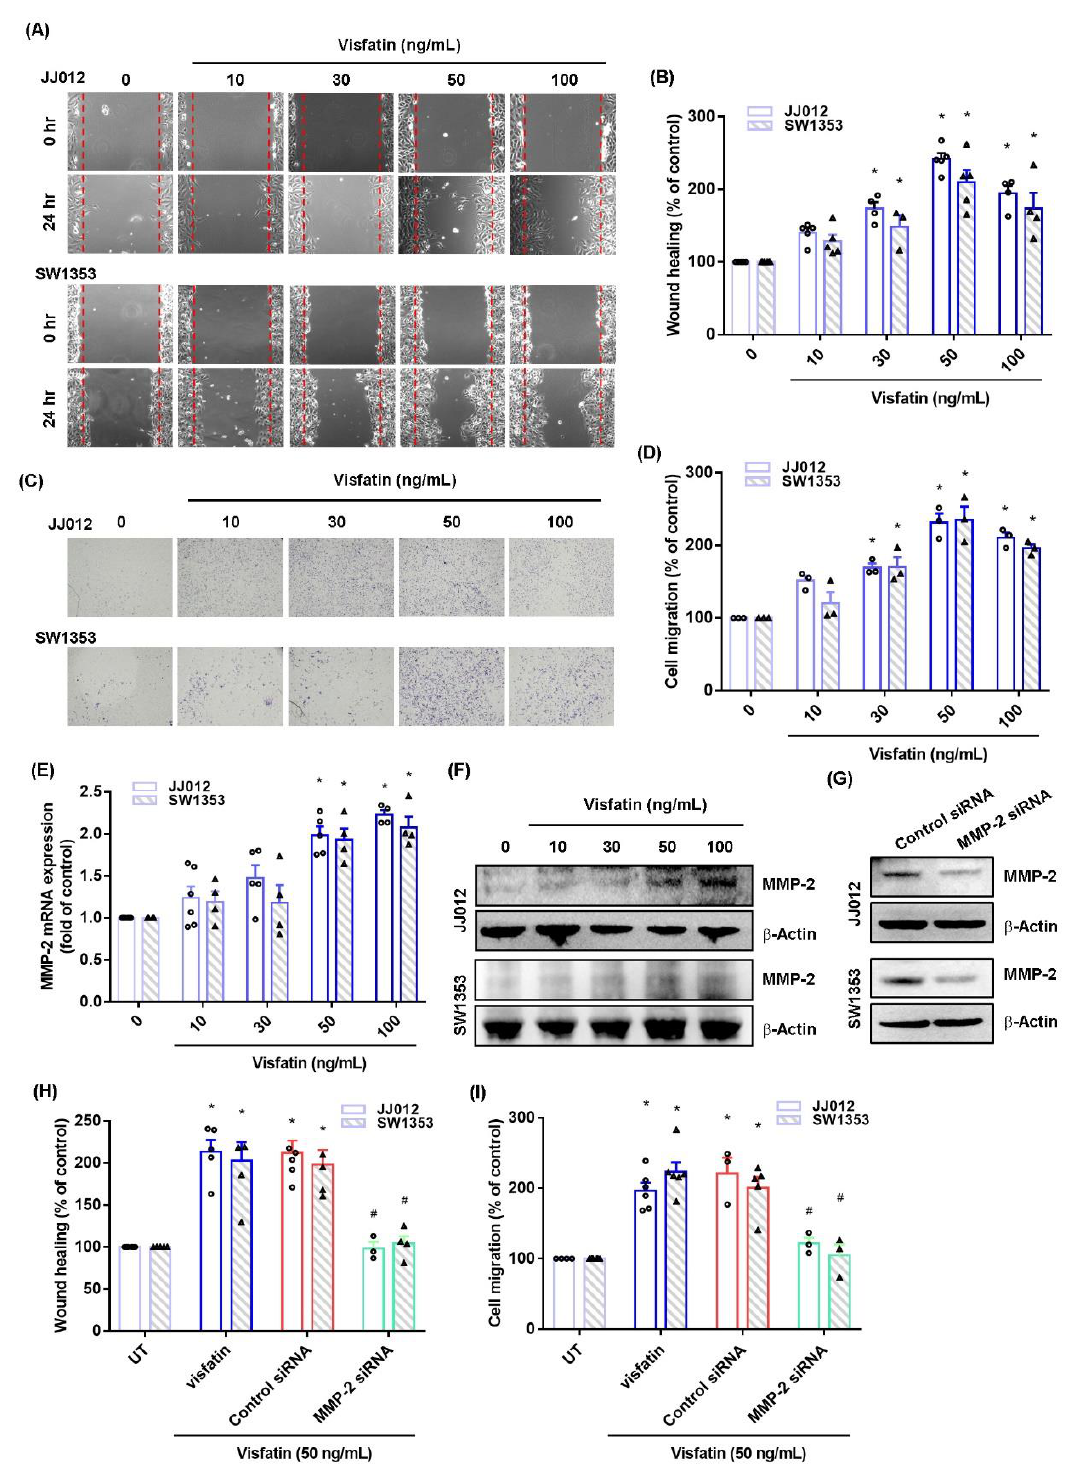
Figure 1. Visfatin promotes MMP-2-dependent cell migration in human chondrosarcoma. ( A – D ) Cells were incubated with visfatin (10–100 ng/mL) and cell migration was examined by Transwell and wound healing assays. ( E , F ) Cells were incubated with visfatin (10–100 ng/mL) and levels of MMP-2 mRNA and protein expression were examined by qPCR and Western blot assays. ( G – I ) Cells were transfected with MMP-2 siRNAs then stimulated with visfatin. Cell migration and MMP-2 expression levels were examined by Transwell, wound healing, and Western blot assays. Quantitative results are expressed as the mean ± SD. All experiments were repeated 3 to 5 times. * p < 0.05 compared with the UT group; # p < 0.05 compared with the visfatin-treated group. UT, untreated